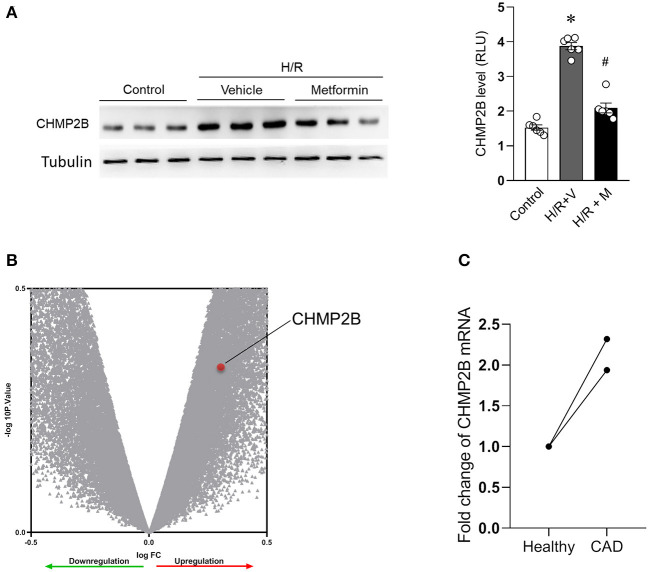
CHMP2B accumulated in hypoxia/reoxygenation and in patients with coronary heart disease. (A) Representative immunoblotting and quantification data of CHMP2B levels in control cells and those subjected to H/R with or without metformin treatment. (B) Total RNA samples from three CAD patients and three healthy people of the Chinese Han population were extracted from peripheral blood and hybridized with Affymetrix microarrays. Volcano plot shows that mRNA expression levels of CHMP2B were upregulated in CAD patients, ~1.9-fold. (C) Fold change of CHMP2B mRNA from three CAD patients and three healthy people. We reanalyzed data from GEO database (GSE71226) for two microarray sites. Values are the means ± SEM, n = 6 per group, *p ≤ 0.05 vs. control group, #p ≤ 0.05 vs. H/R + vehicle group.